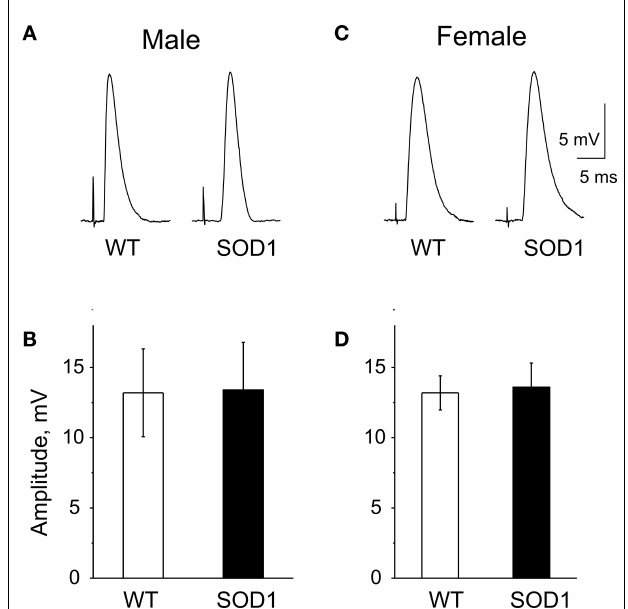
FIGURE 5 | Evoked EPPs in theWT and G93A-SOD1 mice. (A,D) Examples of end-plate potentials (EPPs) inWT, G93A-SOD1 male, and female mice. (B,C) . Histograms showing amplitudes of evoked EPPs inWT, G93A-SOD1 male, and female mice, respectively.